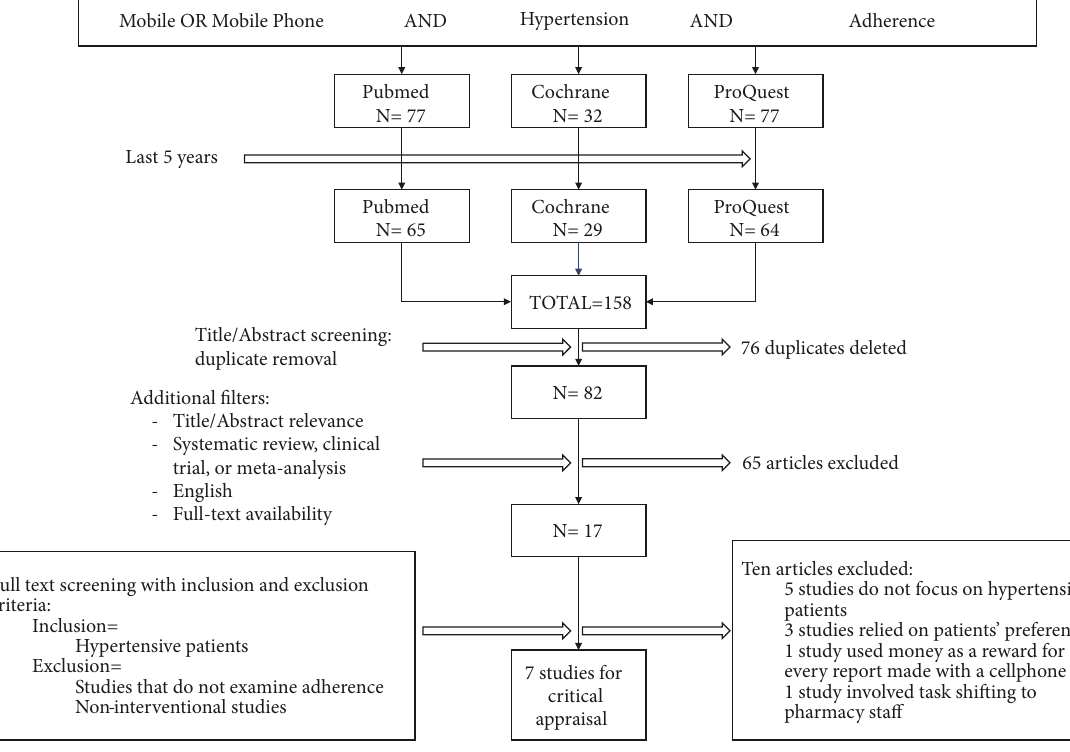
Figure 1: Selection flow chart of the literature review search. Table 1: Keywords and number of findings according to the databases (conducted on December 15th